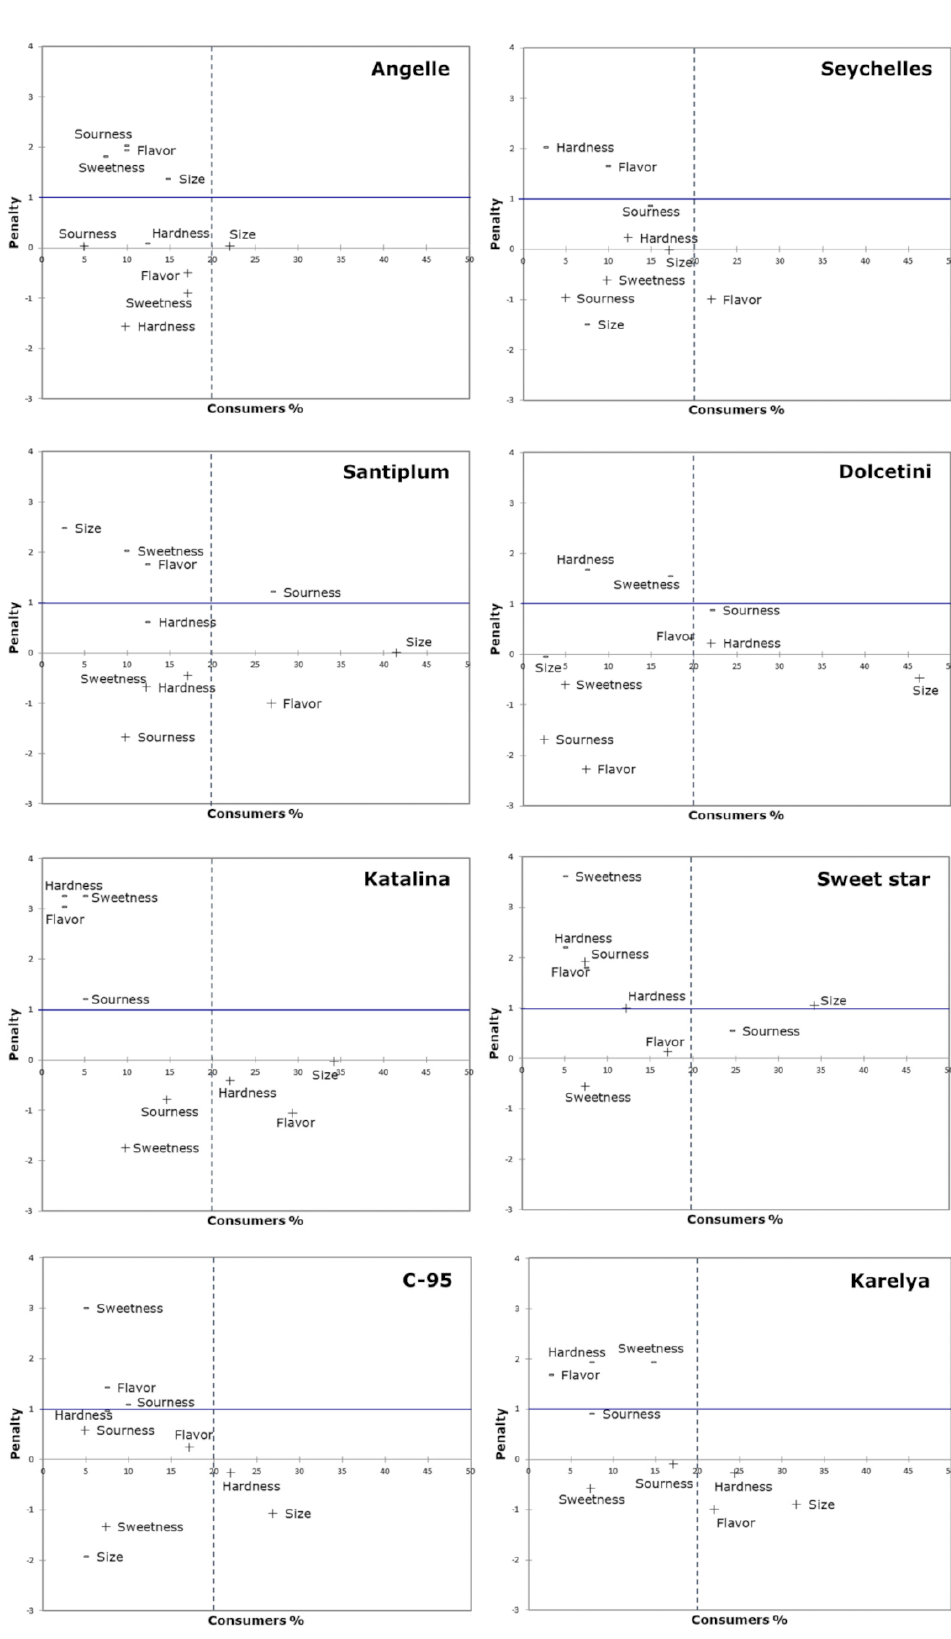
Figure 3. Penalty analysis (PA) of pear and round cherry tomato cultivars. In pear cherry cultivars, consumers evaluated 8 of the 10 attributes reporting similar values for Angelle and Seychelles cultivars. The two attributes which had